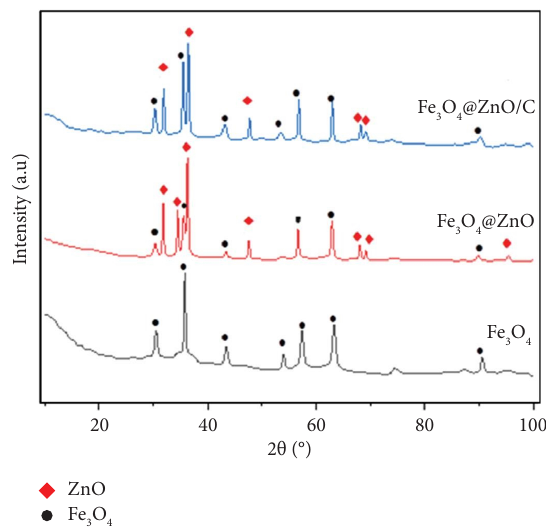
Figure 1: XRD patterns of Fe